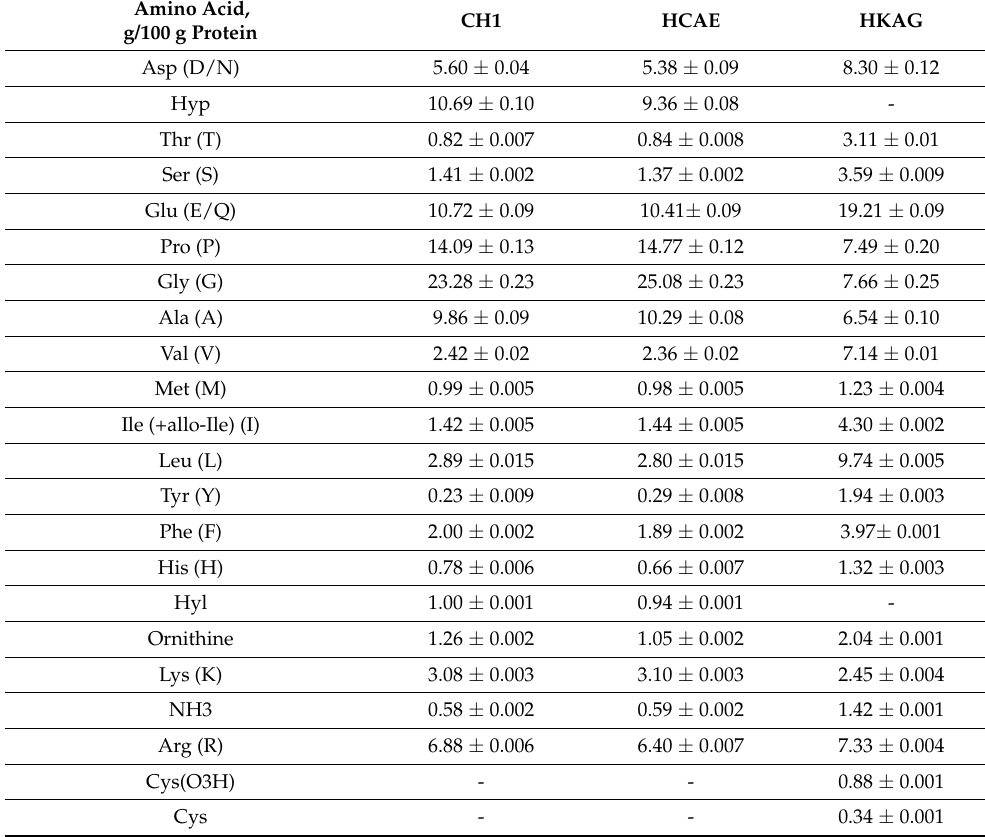
Table 3. Amino acid composition of protein hydrolysates. Amino Acid, g/100 g